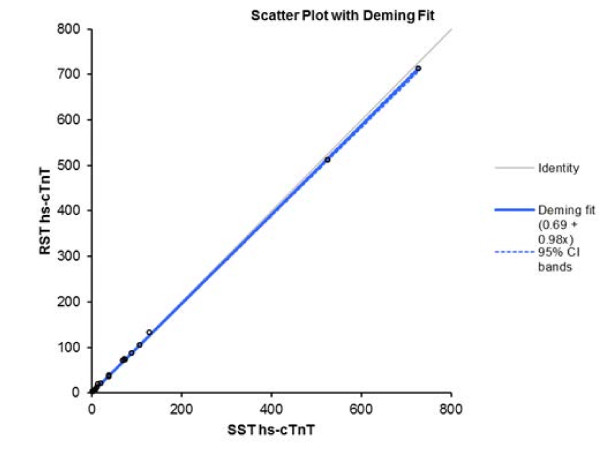
Deming fit (solid black line) with 95% confidence intervals for the SST hs-cTnT results vs RST results. Concentrations are expressed as picograms per milliliter.